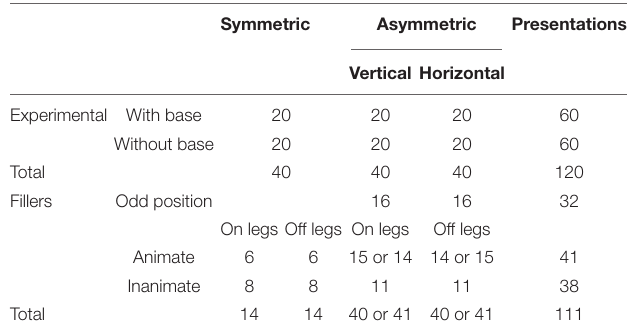
Presentations refers to number of presentations of each